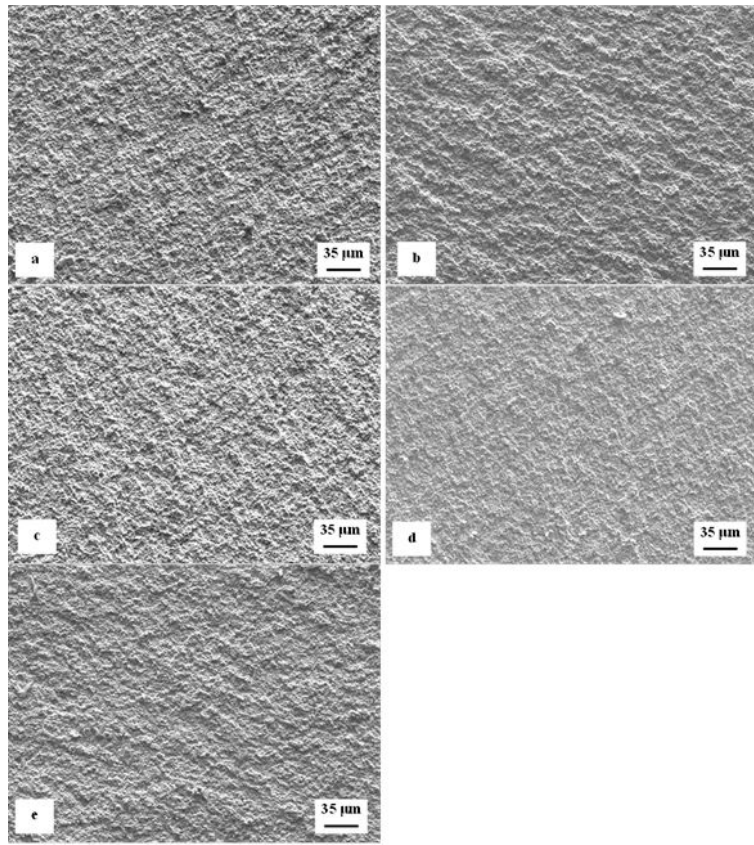
Figure 11. Representative SEM micrographs of the fracture surfaces of sub-zero treated specimens after fracture toughness testing, ( a ) no-tempered, ( b ) tempered at 170 °C, ( c ) tempered at 330 °C, ( d ) tempered at 450 °C, and ( e ) tempered at 530 °C.